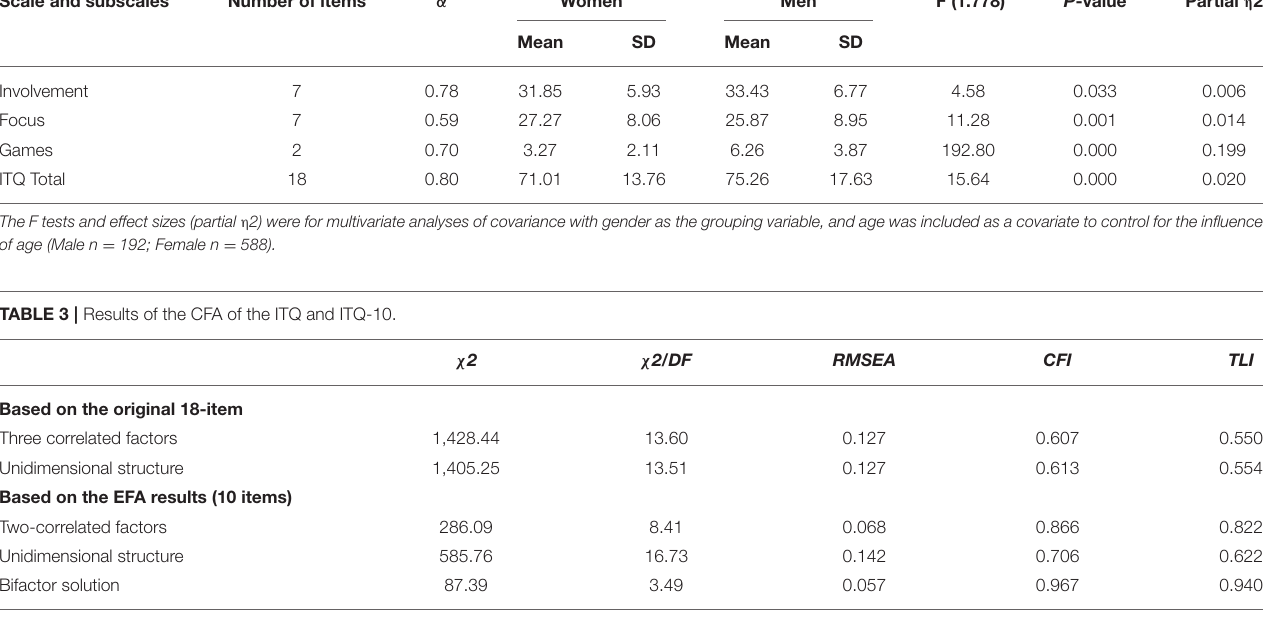
TABLE 2 | Internal consistency reliabilities ( α ), means, standard deviations (SD), and gender differences on the ITQ-18 scale and subscales. Scale and